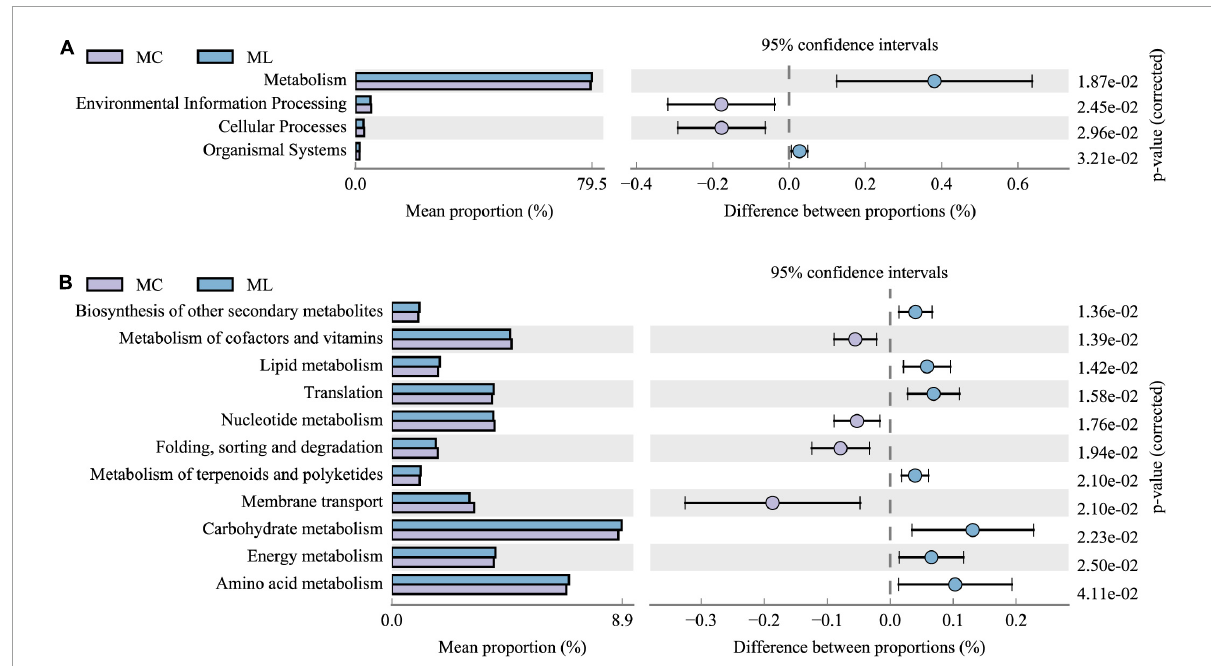
FIGURE6 Comparison of predicted KEGG functions of rumen bacteria in ML vs MC. (Only show functions with gene abundance greater than or equal to 1%). (A) Functional classification level 1, and (B) functional classification level 2. MC, control group ( n = 9); ML, active dry yeast group ( n = 9).